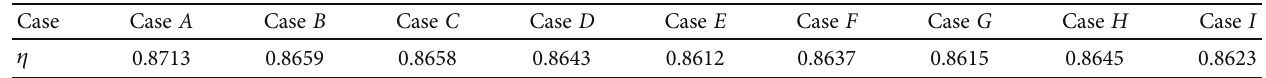
Figure 14: Wall pressure contours near the trailing edge of the cavity of all cases. Table 3: Total pressure recovery coe ffi